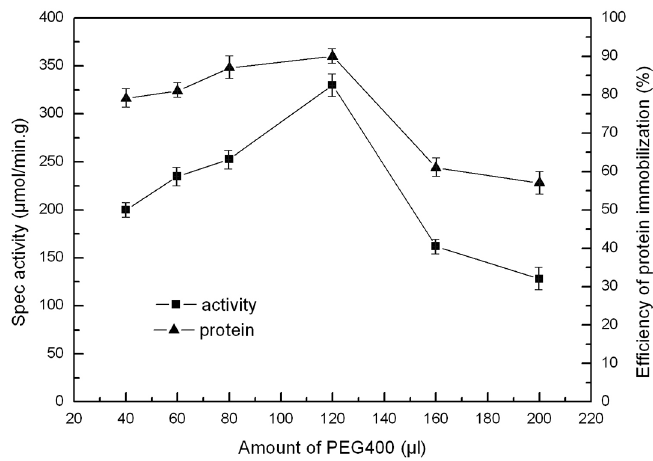
Figure 4. The effect of PEG 400. MTMS/TMOS molar ratio of 5:1, water/silane molar ratio of 12, 120 mg of enzyme supply, 60 mg of SiO 2 .